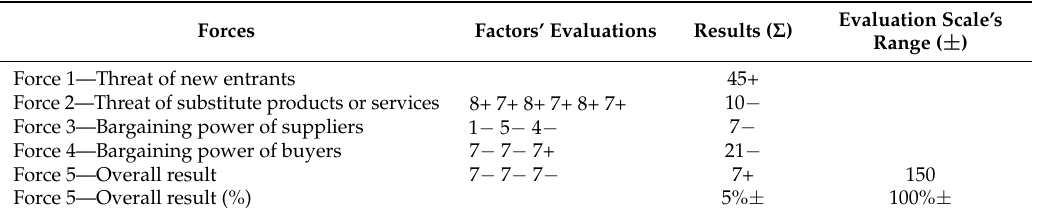
Table 2. Evaluation of the treated factors and related calculations, Porter’s five forces analysis for the electricity market price, EU28 ( ±